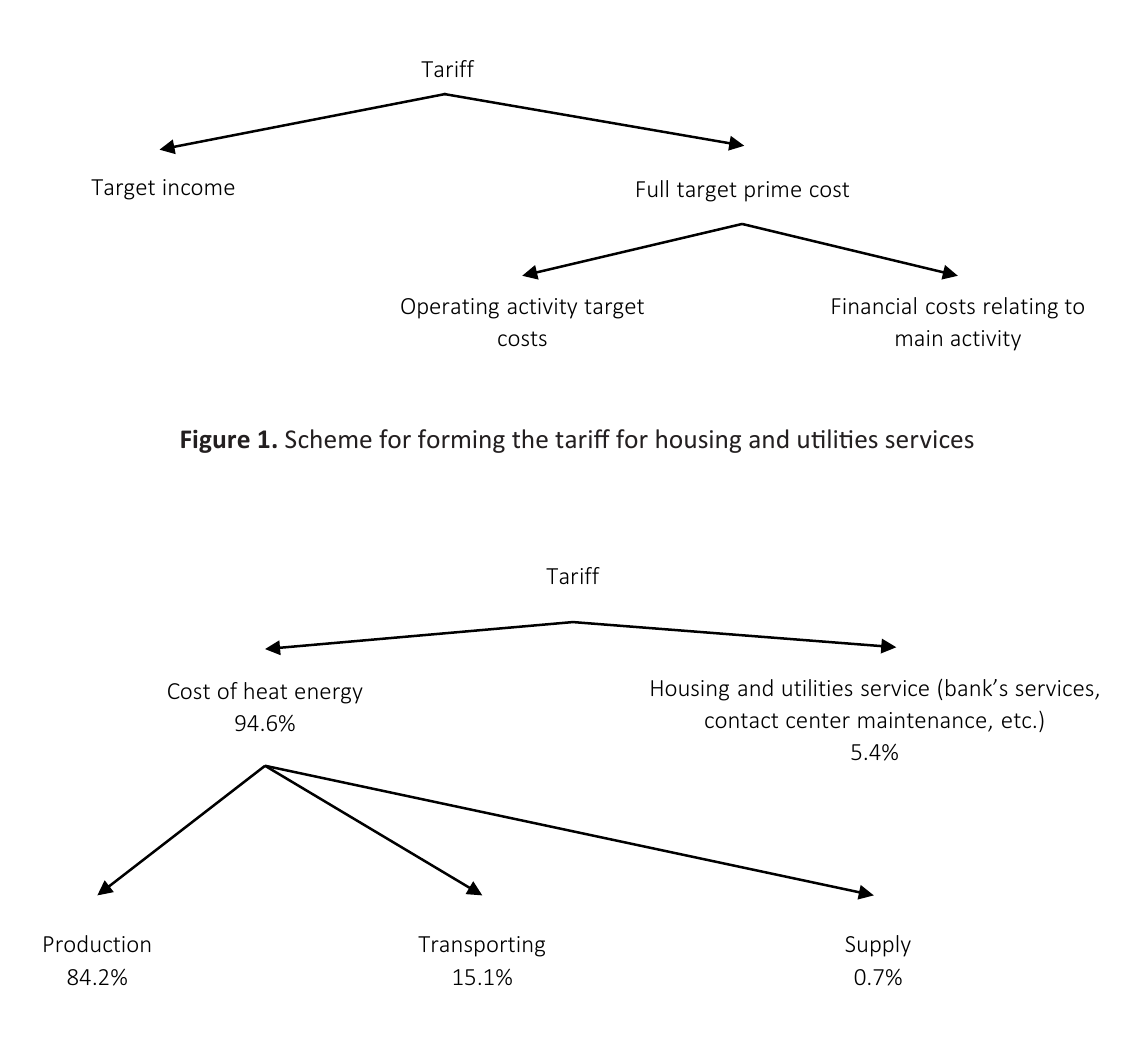
Figure 2. Tariff structure by the example of defining the tariff for heat energy in Lviv